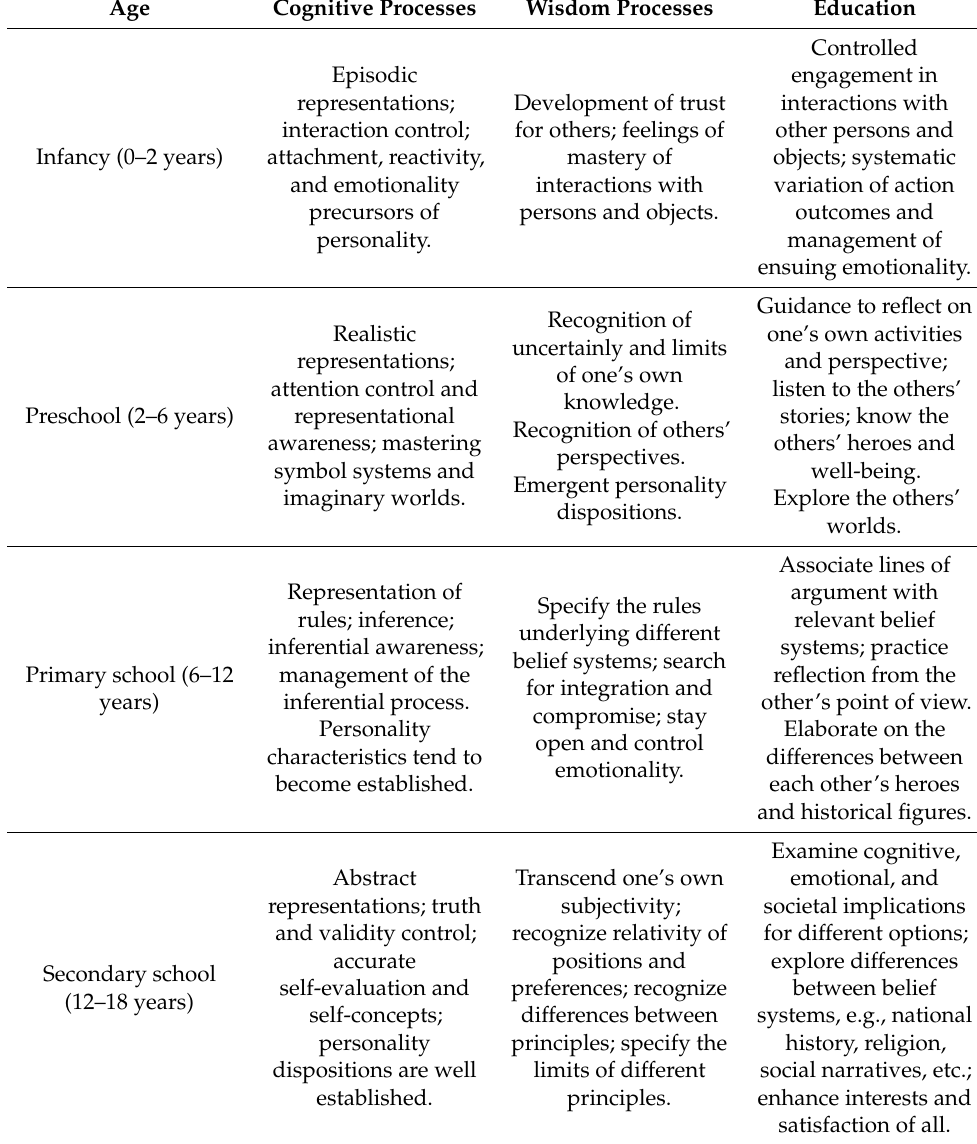
Table 1. Dominant cognitive, wisdom, and educational priorities as a function of